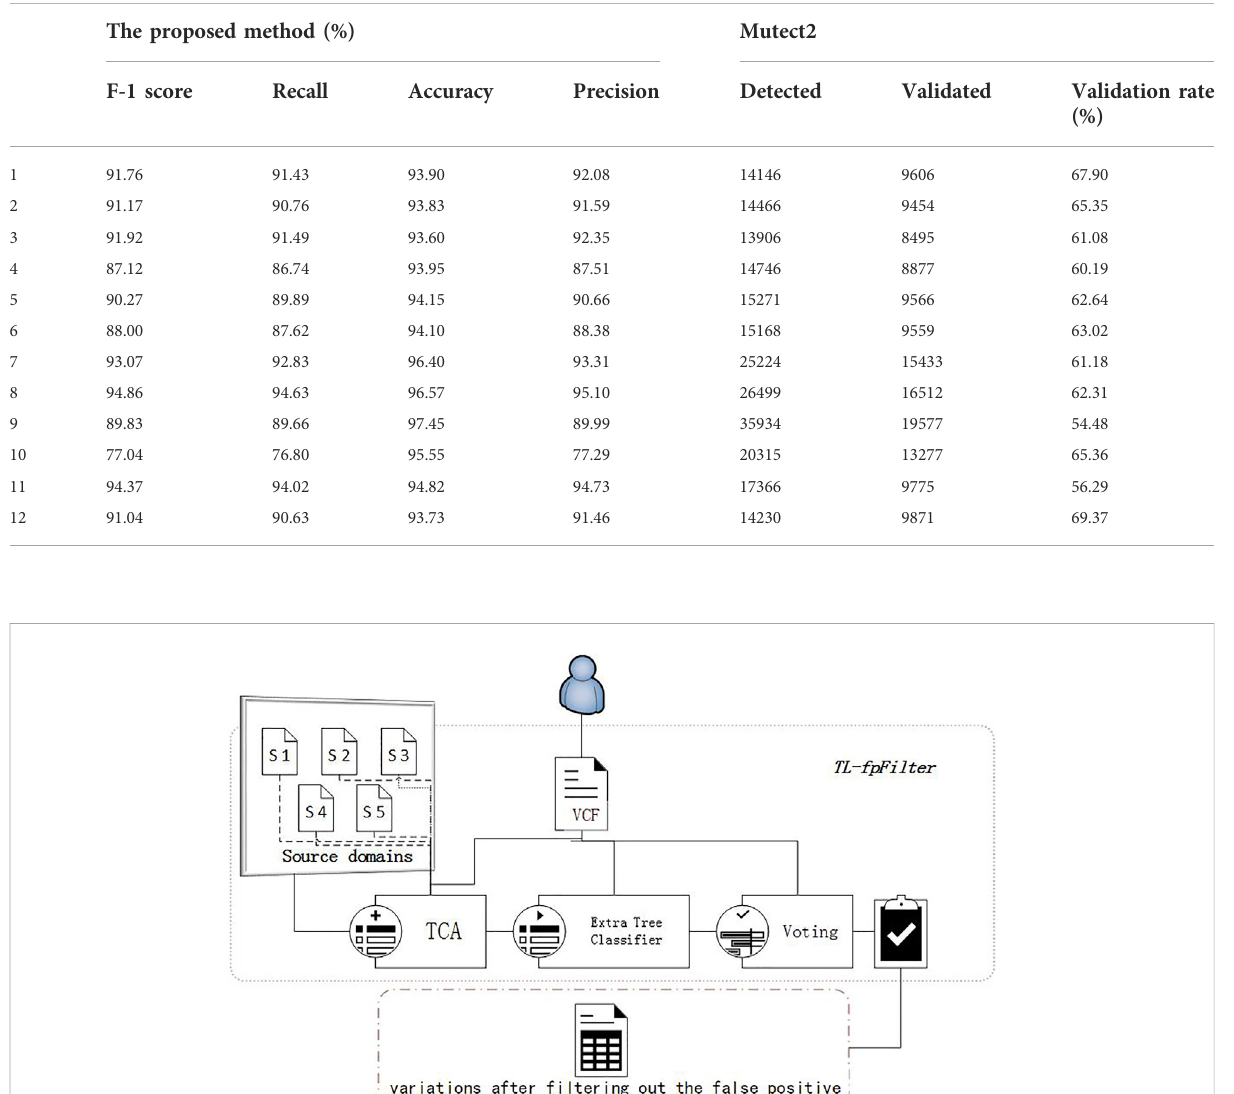
TABLE 7 The experiment results on real datasets.